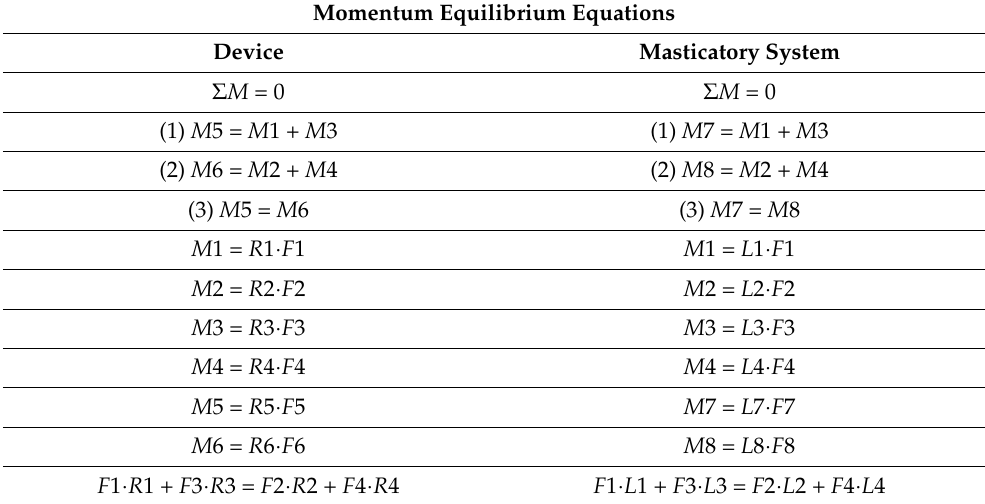
Table A1. Momentum equilibrium equations for the device (left column) and the masticatory system (right column).